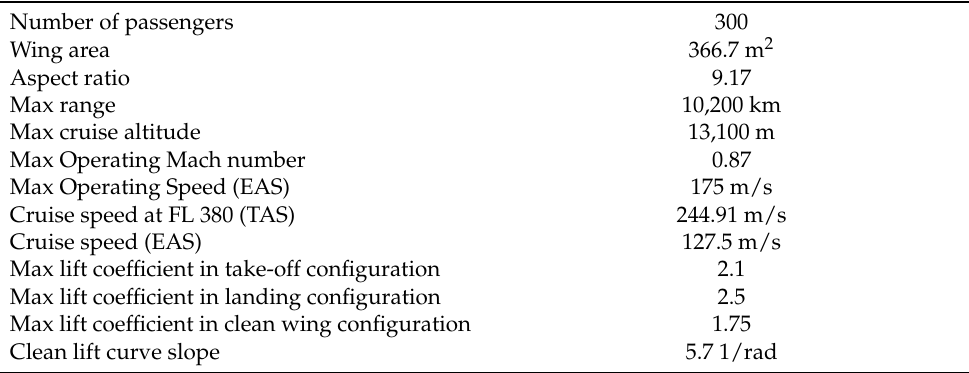
Table 2. TALH main characteristics.